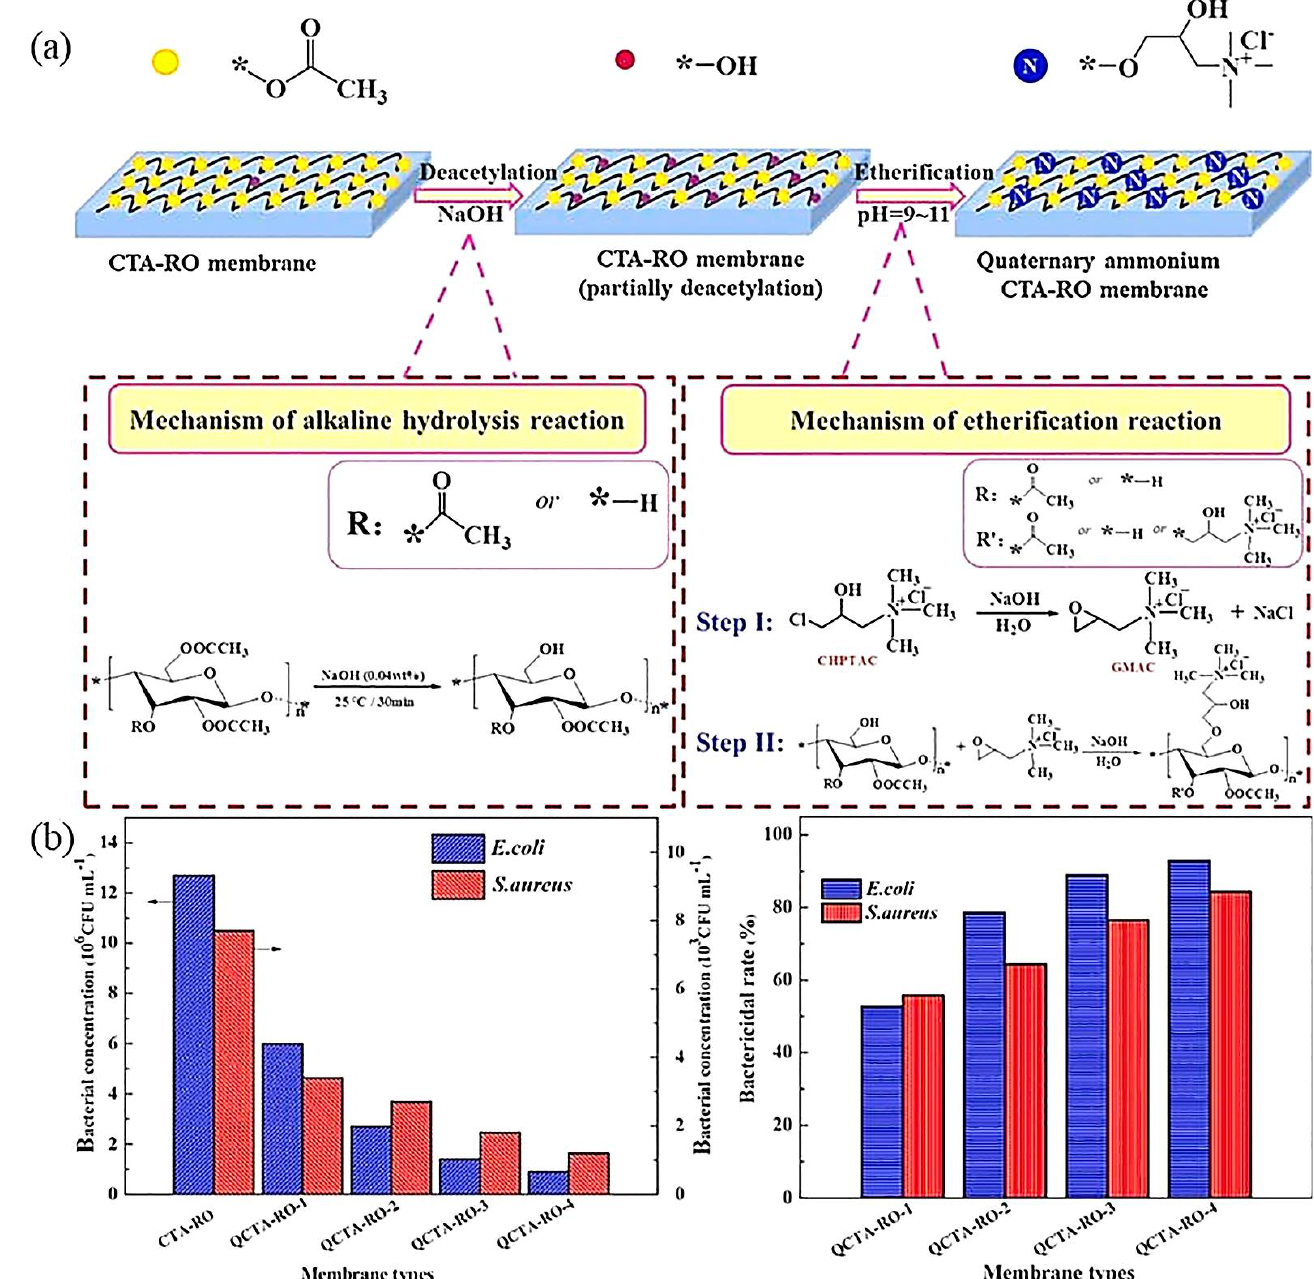
Figure 6. ( a ) Schematic diagram of the quaternization reaction between CTA-RO membrane and CHPTAC. ( b ) Measurement of the bacterial concentration and fungicide rate of the CHPTAC-modified membrane [99]. (Copyright (2018) with permission from Elsevier Ltd.).